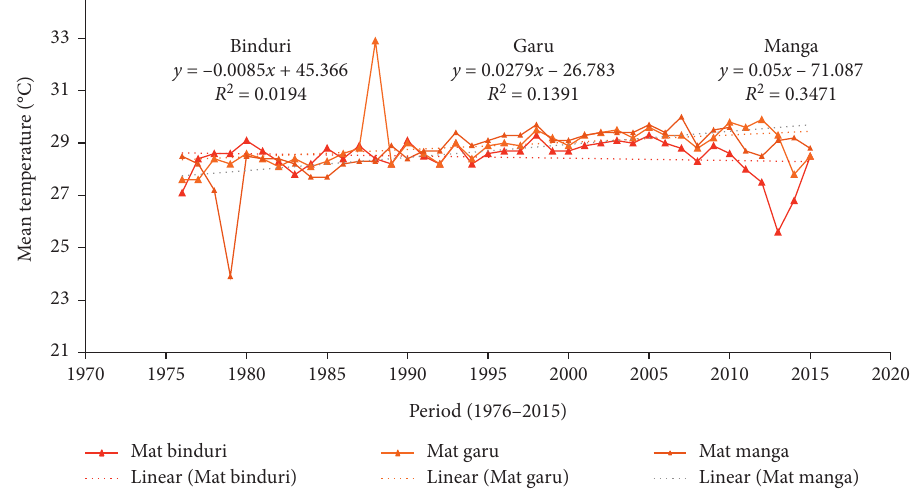
Figure 8: Long-term variability of mean annual